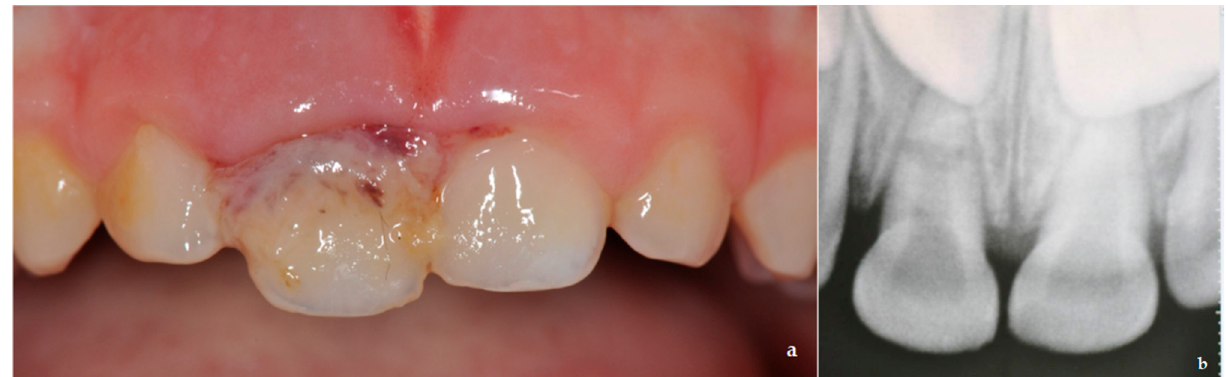
Figure 1. ( a ) Soft tissue lacerations with hematoma and a displacement of 3 mm along the axis of the deciduous maxillary right central incisor (5.1) were observed during intraoral examination; ( b ) periapical radiograph showed root fracture and absence of periodontal ligament (PDL) space alteration.